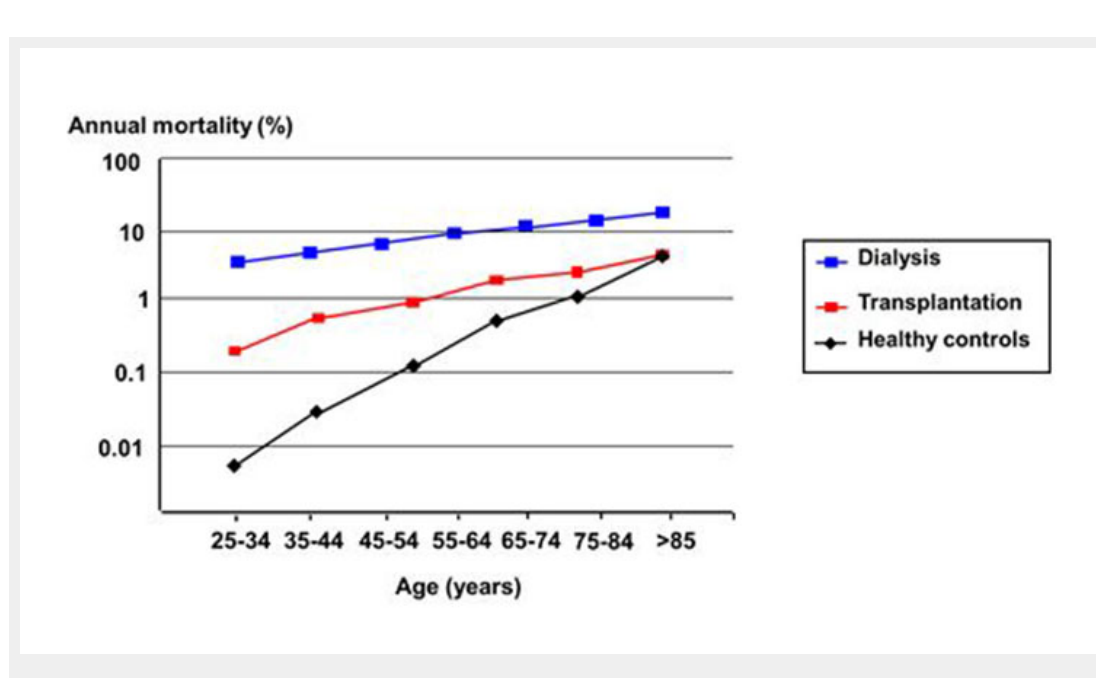
Figure 2 Age dependent mortality rate of US patients with a kidney transplant and of patients on haemodialysis, compared to healthy controls. Data from 1994 to 1996. ( Adapted from [45]: Levey AS, Beto JA, Coronado BE, Eknoyan G, Foley RN, Kasiske BL, et al. Controlling the epidemic of cardiovascular disease in chronic renal disease: what do we know? What do we need to learn? Where do we go from here? National Kidney Foundation Task Force on Cardiovascular Disease. Am J Kidney Dis. 1998;32(5):853–906. With kind permission from Elsevier, Oxford,